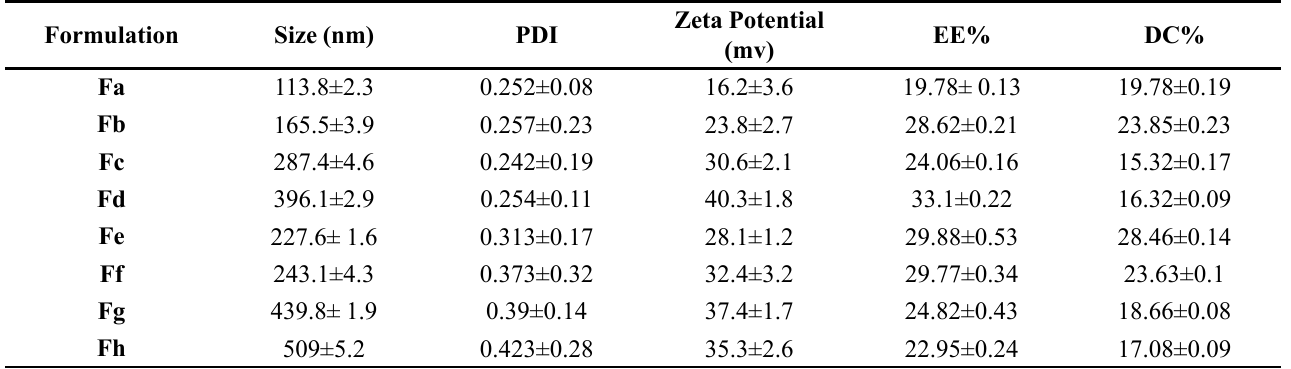
TABLE II - Properties of the different formulations (mean ± SD, n = 3)